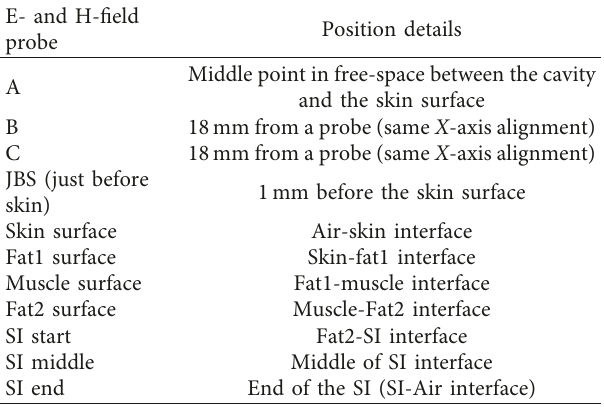
Table 8: Description of E-field and H-field probes.